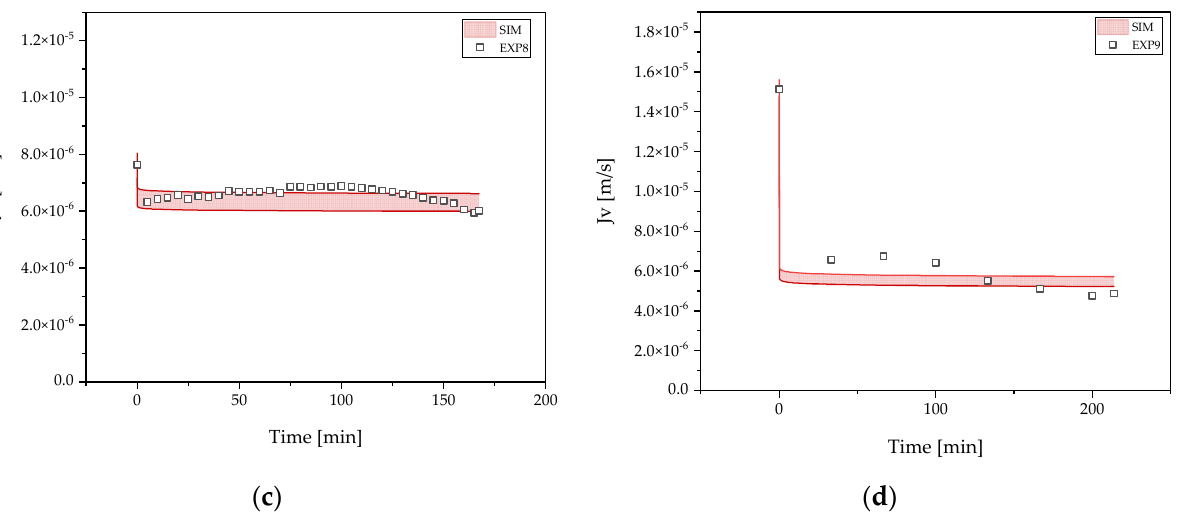
Figure 7. Flux Jv over time for experimental (squares) as well as digital twin prediction (red area) for clarification experiments by ultra-/diafiltration: ( a ) Experiment 1 (EXP1): 1.4 bar transmembrane pressure (TMP), 2062 s − 1 shear rate. ( b ) Experiment 5 (EXP5): 1.3 bar TMP, 11,633 s − 1 shear rate. ( c ): Experiment 8 (EXP8): 1.3 bar TMP, 6071 s − 1 shear rate. ( d ): Experiment 9 (EXP9): 0.8 bar TMP, 6085 s − 1 shear rate.